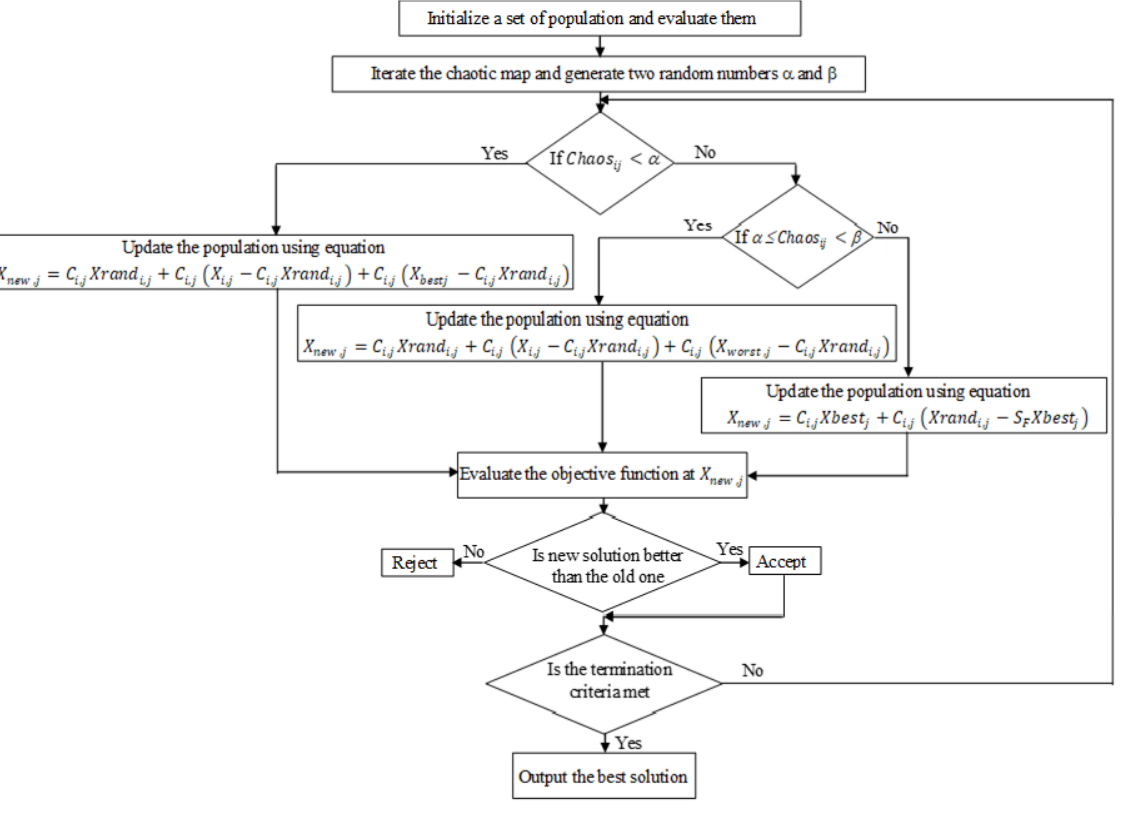
Figure 6. C-JAYA flowchart.